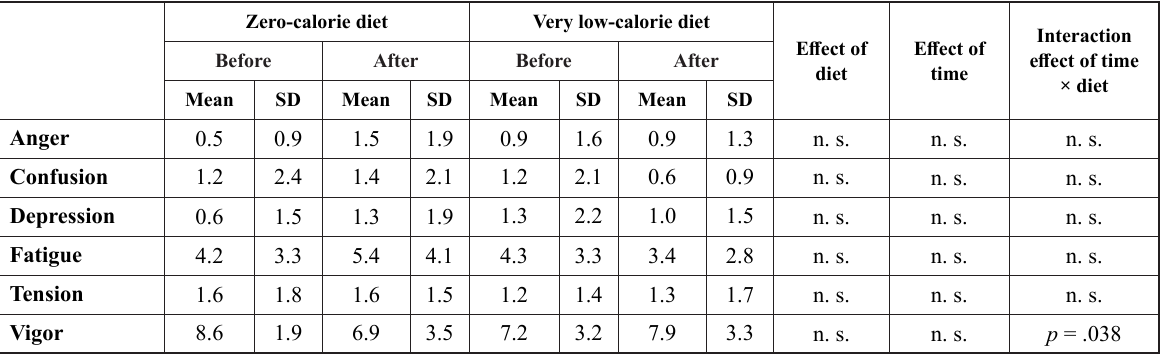
Mood states. The mood states of the participants are reported in Table 3. The significant time × diet interaction was observed only for vigor ( F 1,17 = 5.49, p = .038, SP = 0.60, The zero-calorie diet significantly decreased vigor ( p = .040) 1.7 ± 3.2 of initial state, whereas this state remained unchanged during the very low-calorie diet. Greater decrement for vigor ( p = .038) was observed after zero-calorie diet when compared to very low-calorie diet. Table 3. The effect of 2-day diets on the mood Inhibitory control. Data of inhibitory control requiring tasks are reported in Table 4. There was no significant effect of time and diet, or the time × diet interaction on the inhibitory control.